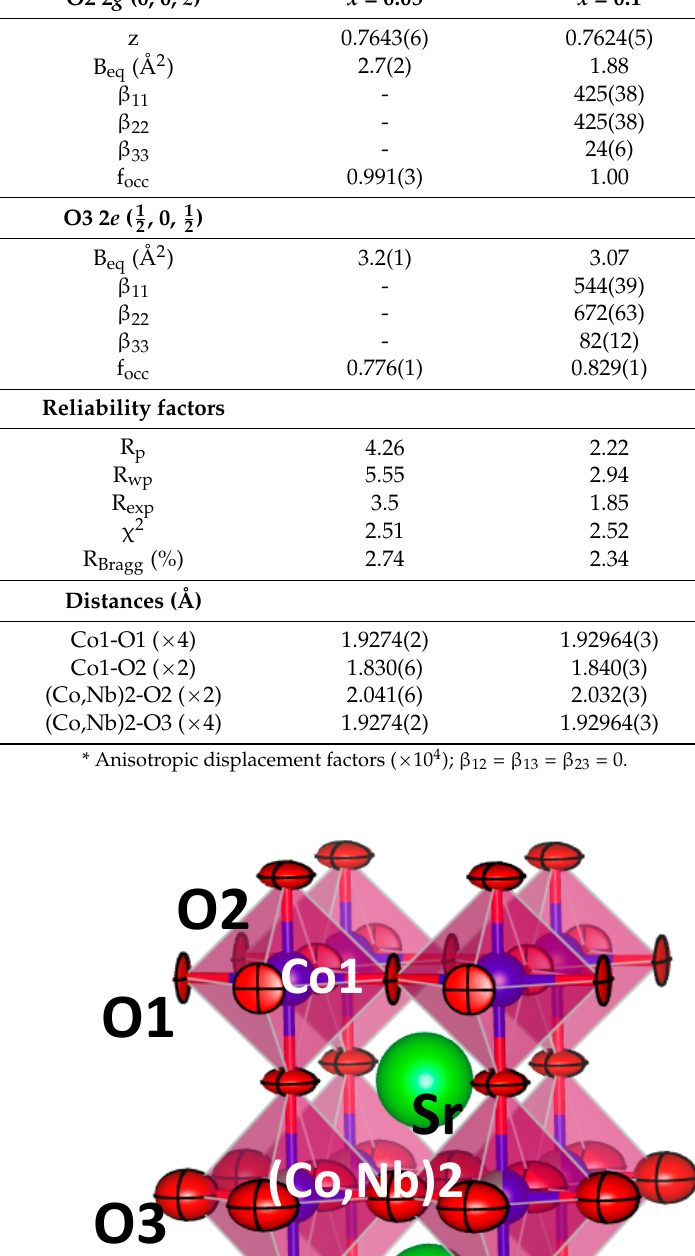
0.9 Nb 0.1 O 3 ´ δ from NPD data at